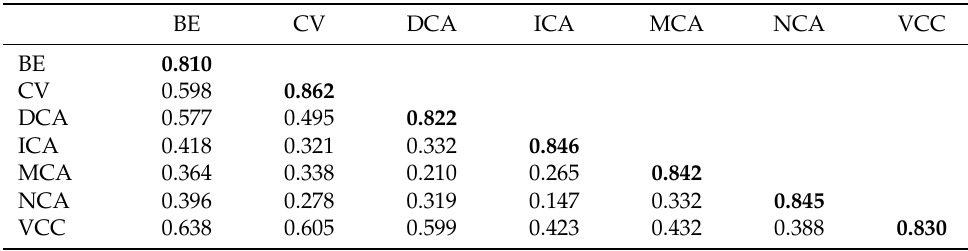
Table 3. Fornell–Larcker criteria.